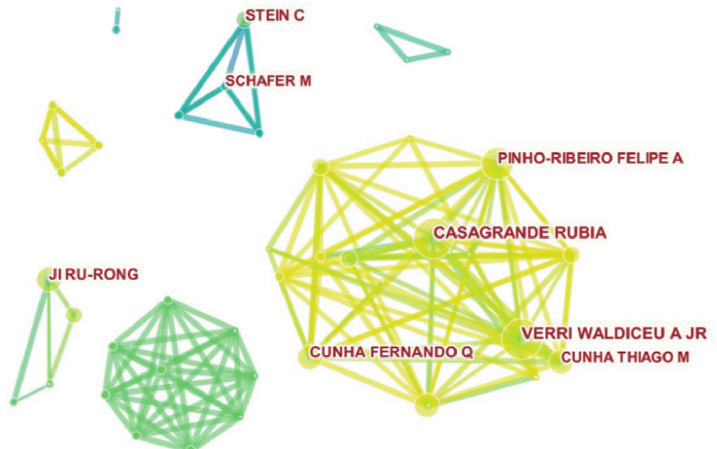
Figure 9: The analysis of authors. Network map of active authors who contributed to pain and inflammation